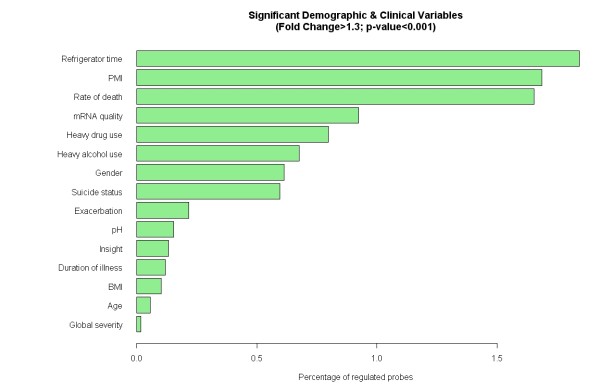
Individual demographic and clinical variable analyses. Three variables including refrigerator time, PMI and rate of death affected more than 1% of the transcripts in the liver (fold change >1.3 and p < 0.001). Other variables such as mRNA quality, heavy drug use, heavy alcohol use, gender and suicide status affected the expression levels in the range of 0.5-1%.